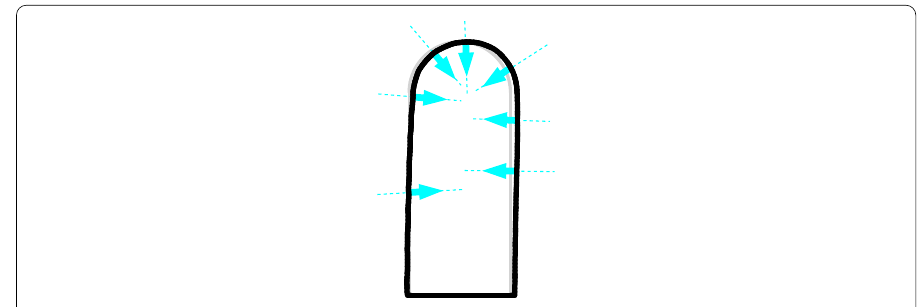
Fig. 21 Measurement points and directions as arrows indicating the positive directions for biofilm example with surface growth on the edges of the actual grown and deformed geometry of the reference result (black) and initial geometry (gray)